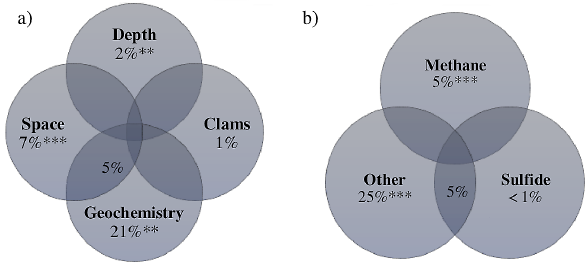
Fig. 5. Variation partitioning analysis. Effect (%) of the geochem- istry (concentrations of CH 4 , H 2 S, Cl, Fe, Mn, PO 4 , SO 4 , pH), clams presence (clams directly influence the top 6cm sediment), space (geographic distance among sampling sites) and depth (sed- iment depth) on the bacterial diversity at REGAB (a) . Geochem- istry, followed by space and depth, significantly shape the diversity at REGAB. Visualization of the individual influence of CH 4 and H 2 S on the bacterial community structure (b) . Other = all param- eters included in (a) , excluding CH 4 and H 2 S individually. CH 4 ( p < 0 . 001) significantly explains the variation in the ARISA data set. *** p < 0 . 001, ** p < 0 . 002, * p < 0 . 03. The complete model explained 36% of the total variation in the bacterial diversity at RE-